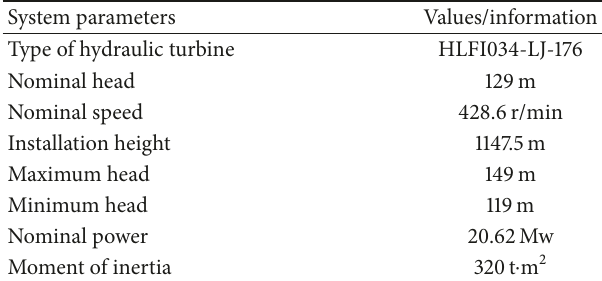
Table 2: Hydraulic turbine information of an existing